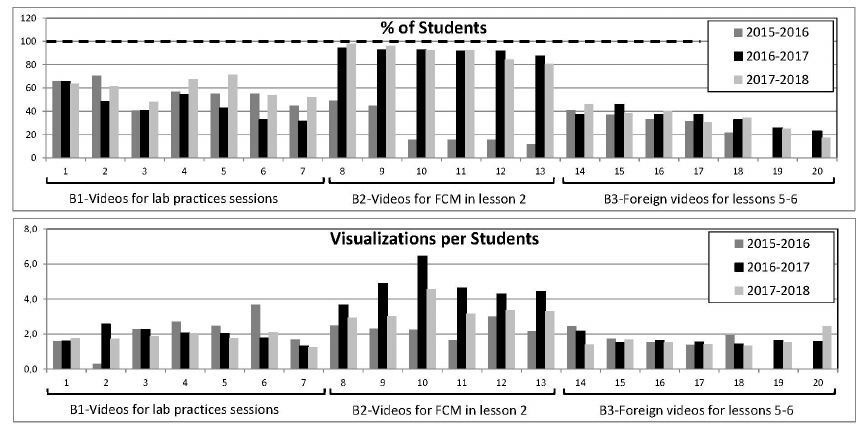
Figure 3. Summary about the use of educational videos.